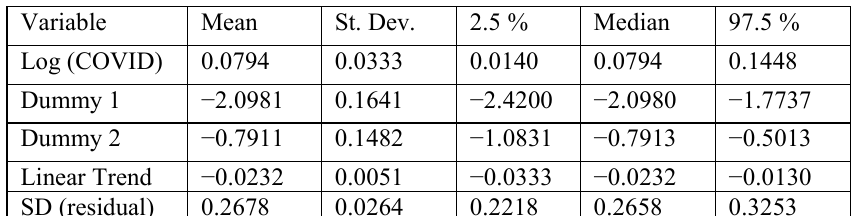
Table 3. Summary of the Estimation